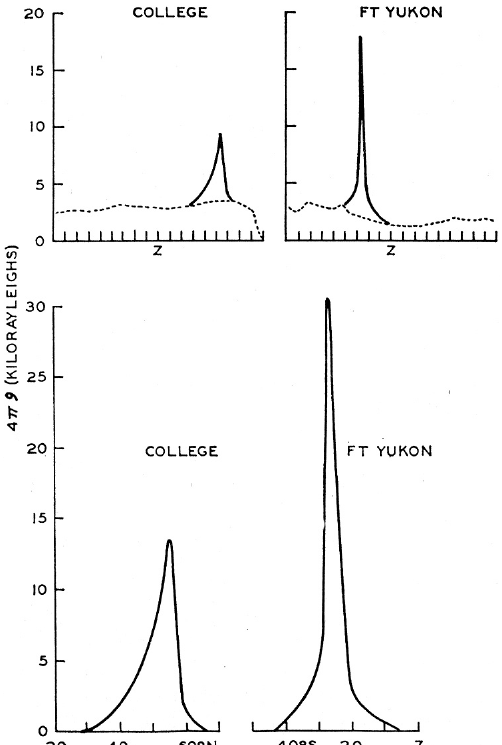
Fig. 1. The location along the 256 ◦ magnetic longitude and extent of observations from the two Alaskan stations used in this study of the altitude of discrete auroral arcs by photometric triangulation.